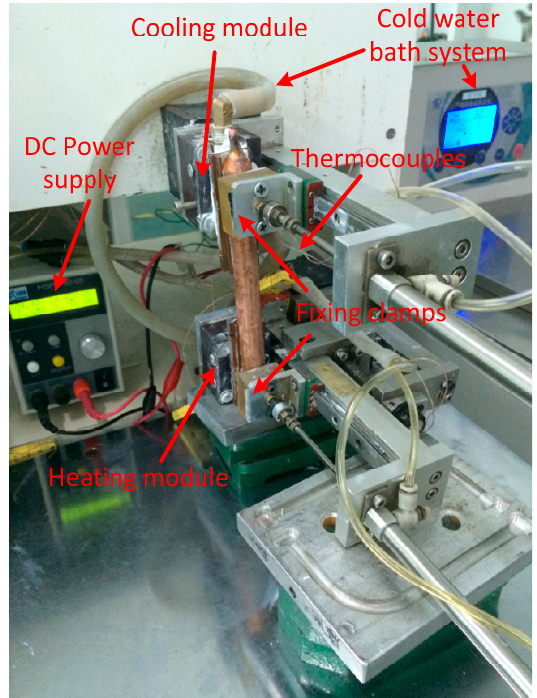
Figure 4. Thermal performance test setup.